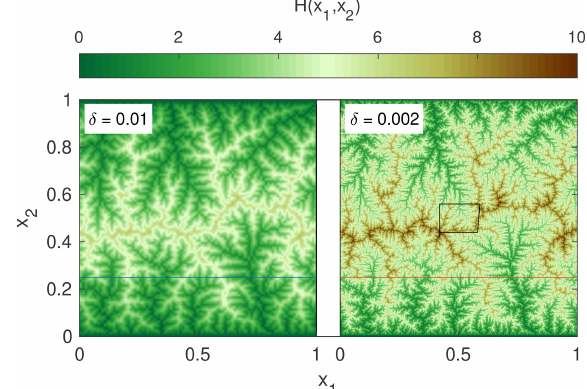
Figure 1. Fluvial equilibrium topographies computed for identical parameter values on grids with different spacing ( δ = 0 . 01, 100 × 100 nodes, and δ = 0 . 002, 500 × 500 nodes). The horizontal lines refer to the profiles analyzed in Fig. 2 and the rectangle to the region shown in Fig. 4.